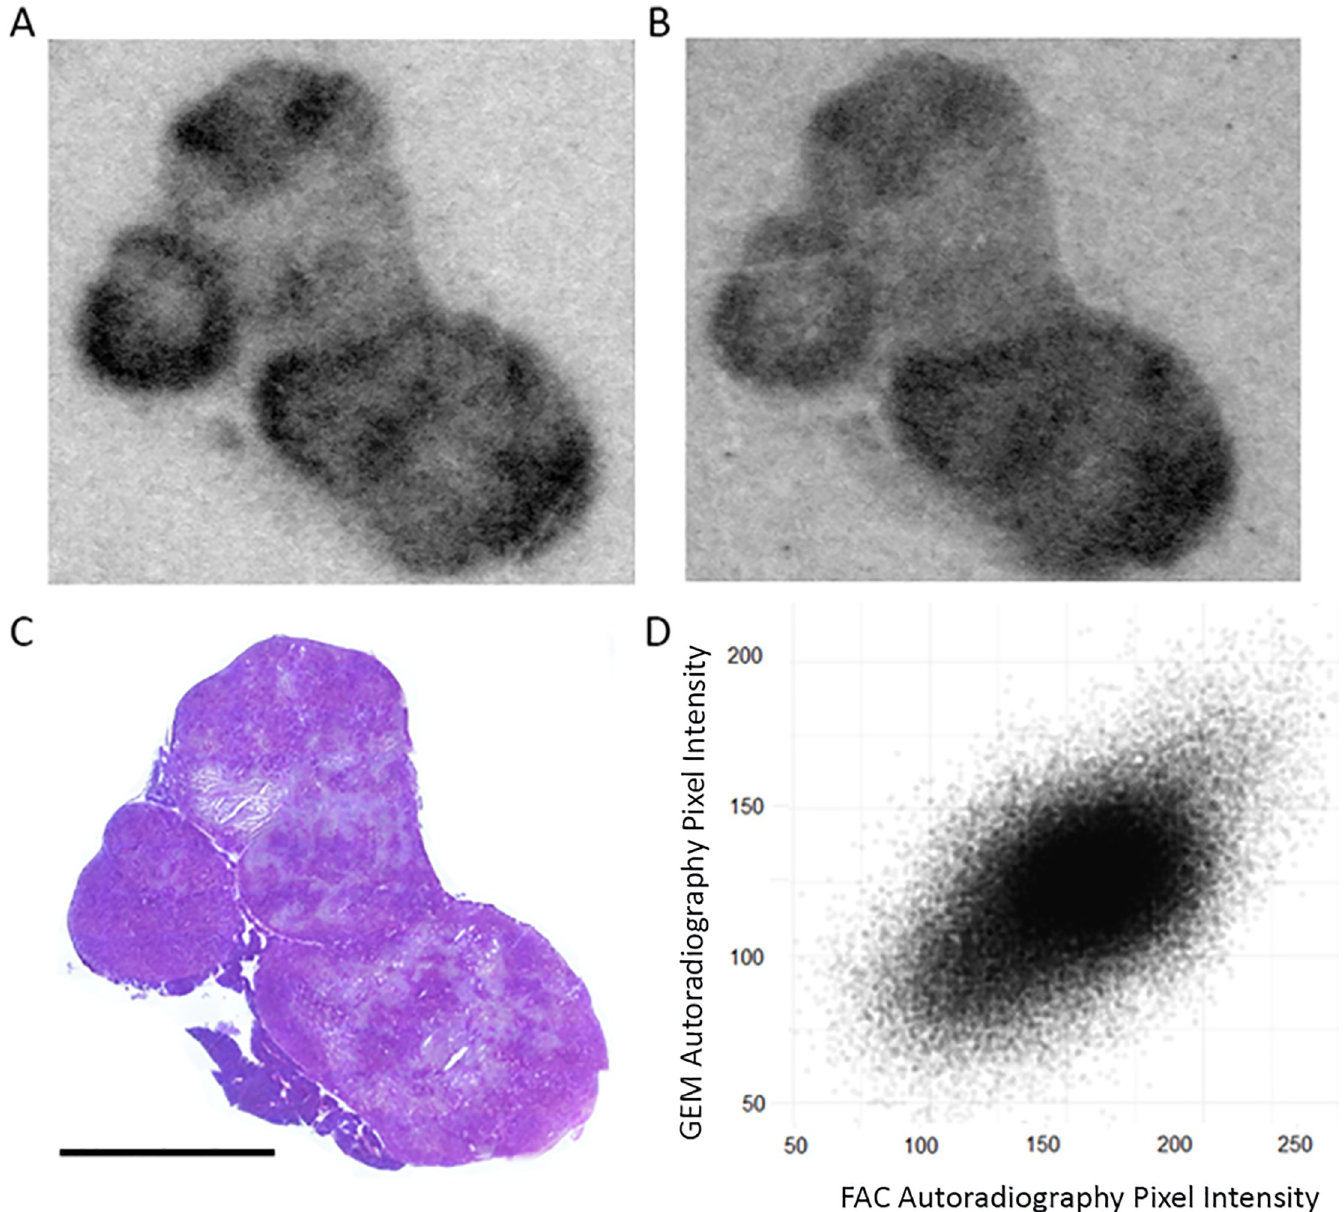
Fig 3. Gemcitabine and FAC co-localization. Autoradiography of [ 14 C]-gemcitabine (A) and of [ 18 F]-FAC (B) in an organoid tumor section. H&E staining of that tumor section (C) and pixel to pixel correlation of pixel intensity between [ 14 C]-Gemcitabine and [ 18 F]-FAC autoradiography (D). Scale bar is 5 mm. https://doi.org/10.1371/journal.pone.0231745.g003 tumor, which is matched by [ 14 C]-5-FU. However, 3 H signal from capecitabine shows a much more uniform distribution across the tumor section. This same pattern was observed in all studied tumors. This results in a weak to nonexistent correlation between [ 18 F]-FAC and [ 3 H]- capecitabine-derived activity. In contrast, there is a good correlation between [ 18 F]-FAC and [ 14 C]-5-FU derived activity, that is only slightly less than between [ 18 F]-FAC and [ 14 C]-gemci- tabine. Visually, the hotspots on the [ 14 C]-5-FU autoradiographs correspond to the [ 18 F]-FAC hotspots. Thus, it seems reasonable that 5-FU, FAC and gemcitabine share similar intra-tumor